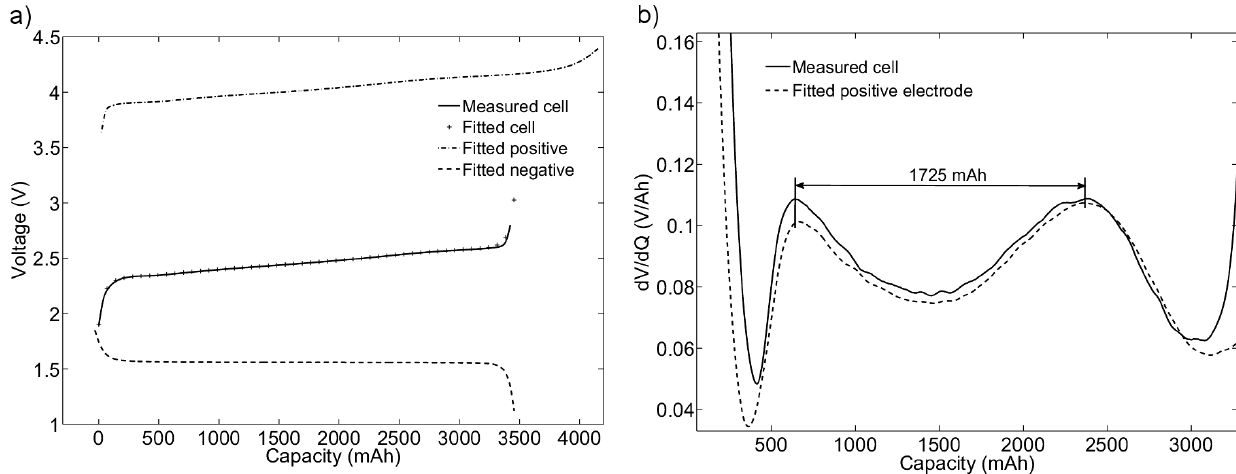
Figure 6. ( a ) Internal cell matching for a fresh cell. ( b ) Fitted positive electrode d V /d Q -data to full cell d V /d Q